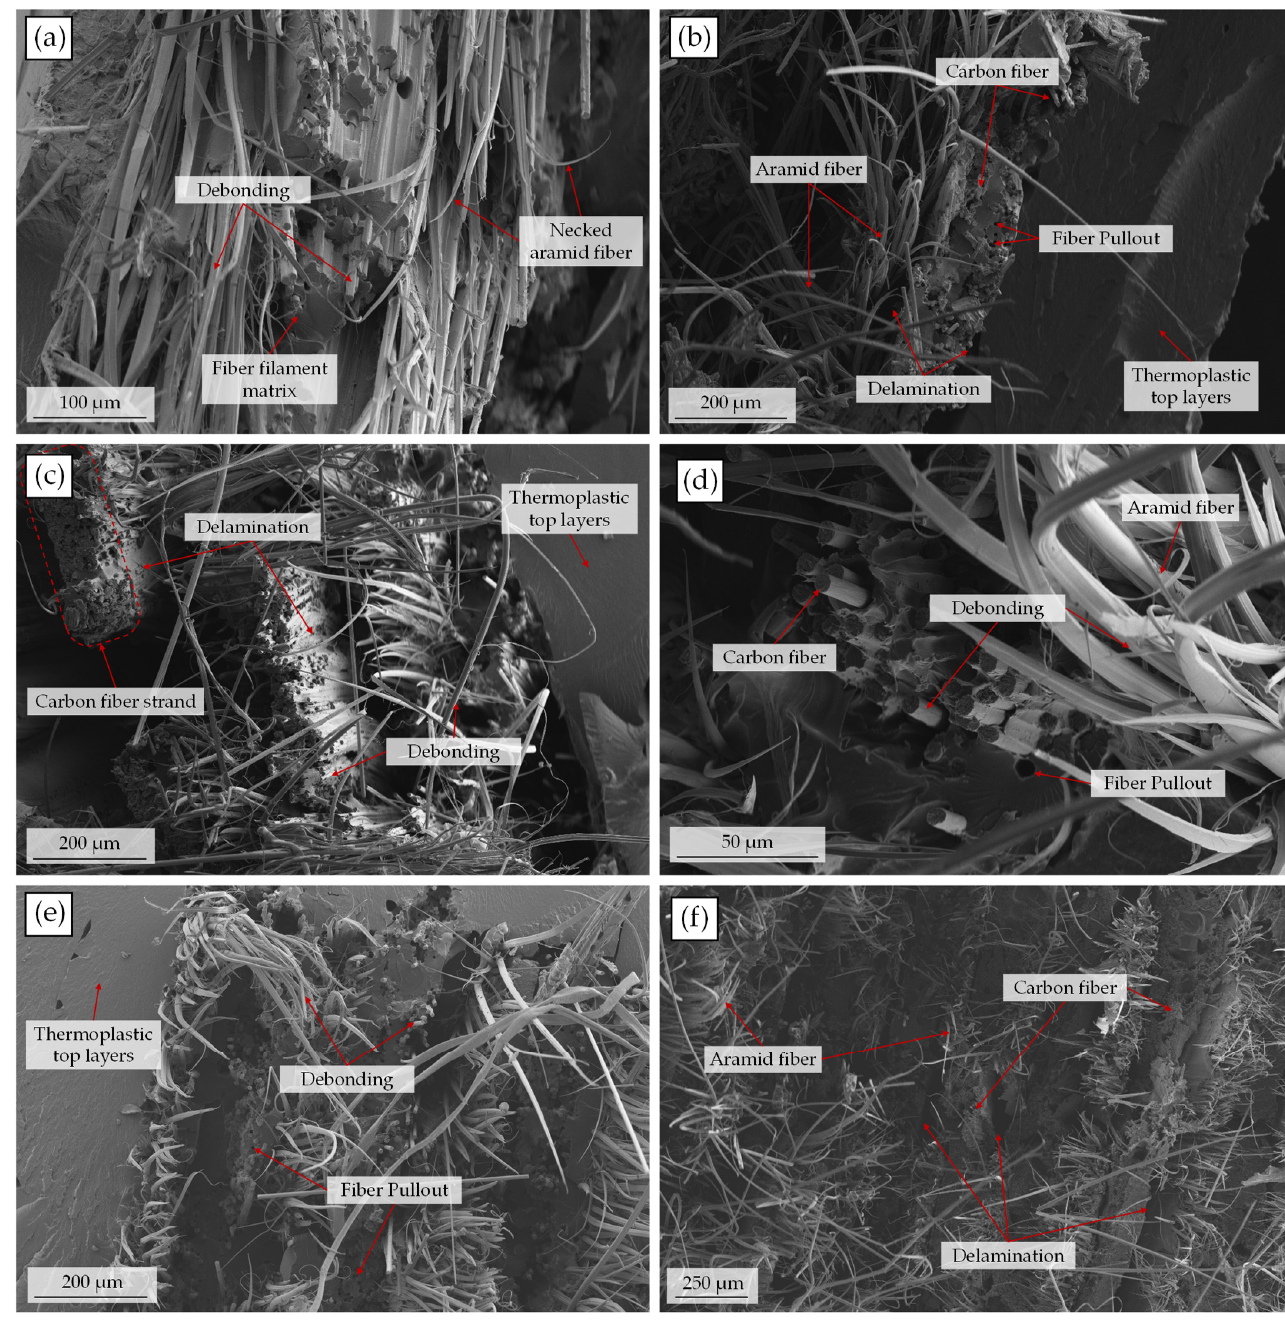
Figure 9. SEM images of the fracture surfaces of specimens with 50% relative carbon and aramid fiber content respectively: ( a , b ) tensile specimen; ( c , d ) flexural specimen; ( e , f ) impact